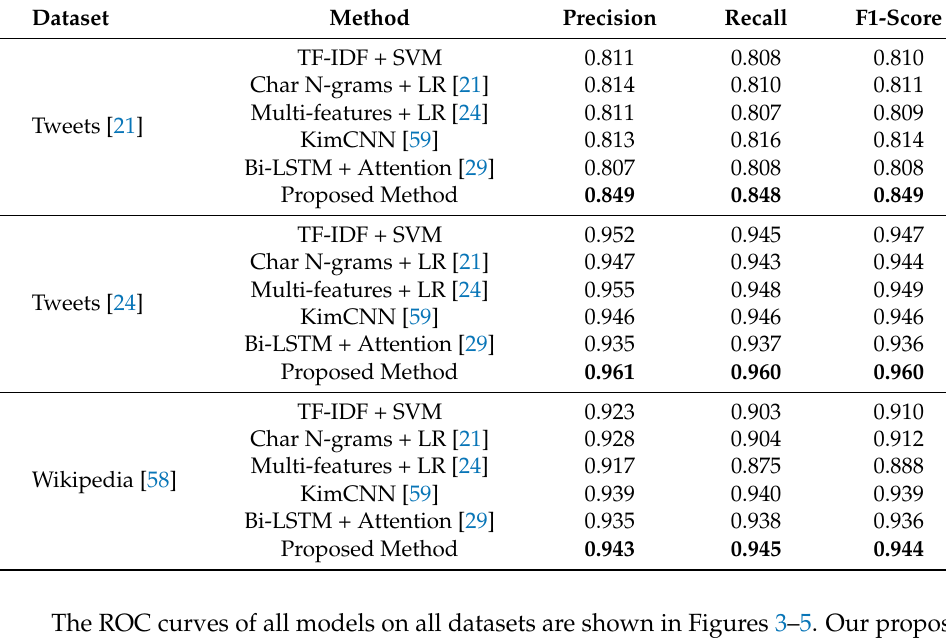
Table 5. Experiment Result for Total Weighted Average.